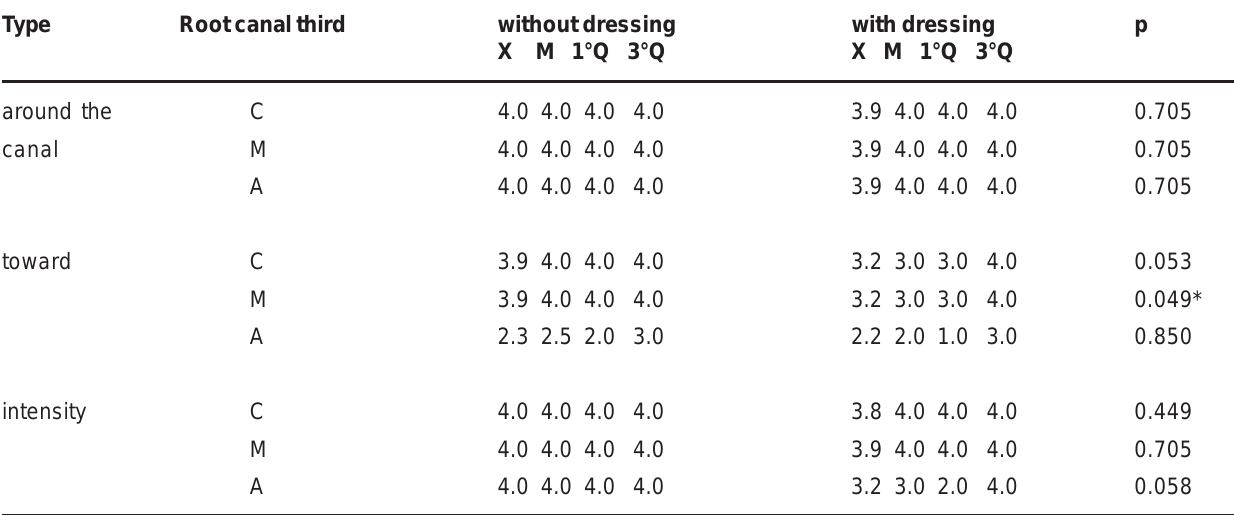
TABLE 3- Values for mean (X), median (M), 1 st quarter (1 st Q), 3 rd quarter (3 rd Q) and probability (p), for the scores given in the groups of rhodamine B in the conditions with and without